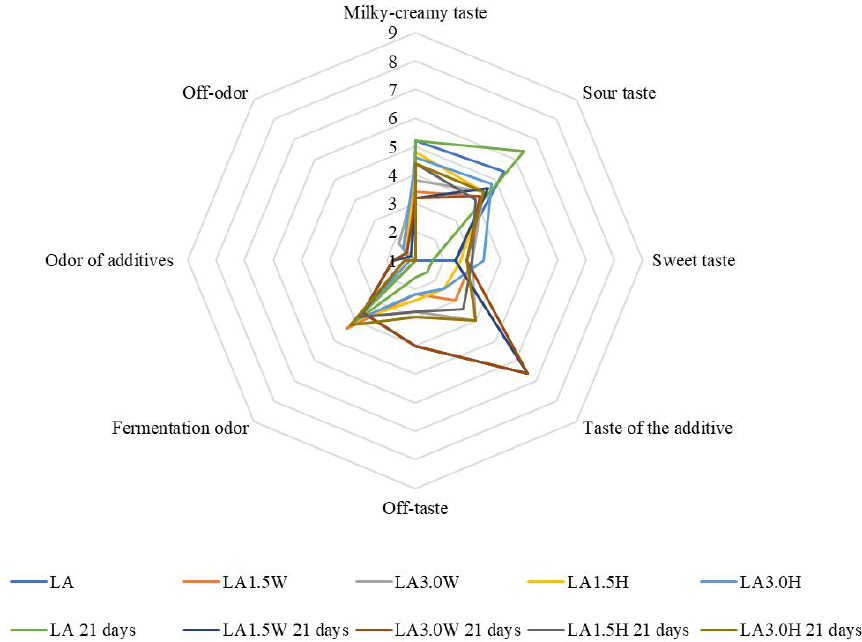
Figure 2. Effect of collagen addition on the organoleptic parameters of milk fermented by L. acidophilus after 1 and 21 days of cold storage. LA—control milk with Lactobacillus acidophilus ; LA1.5W—milk with 1.5% collagen and Lactobacillus acidophilus ; LA3.0W—milk with 3.0% collagen and Lactobacillus acidophilus ; LA1.5H—milk with 1.5% collagen hydrolysate and Lactobacillus acidophilus ; LA3.0H—milk with 3.0% collagen hydrolysate and Lactobacillus acidophilus .